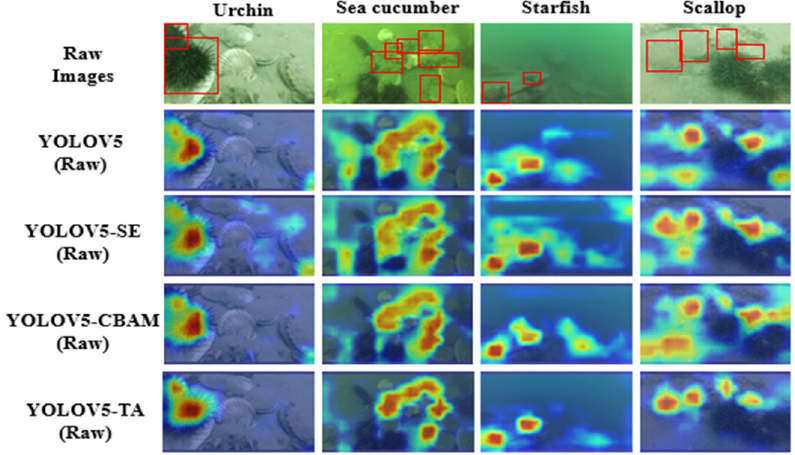
Figure 6. Visualization of Grad-CAM results for each species of marine organisms; the ground truth in the raw images is marked with red boxes.